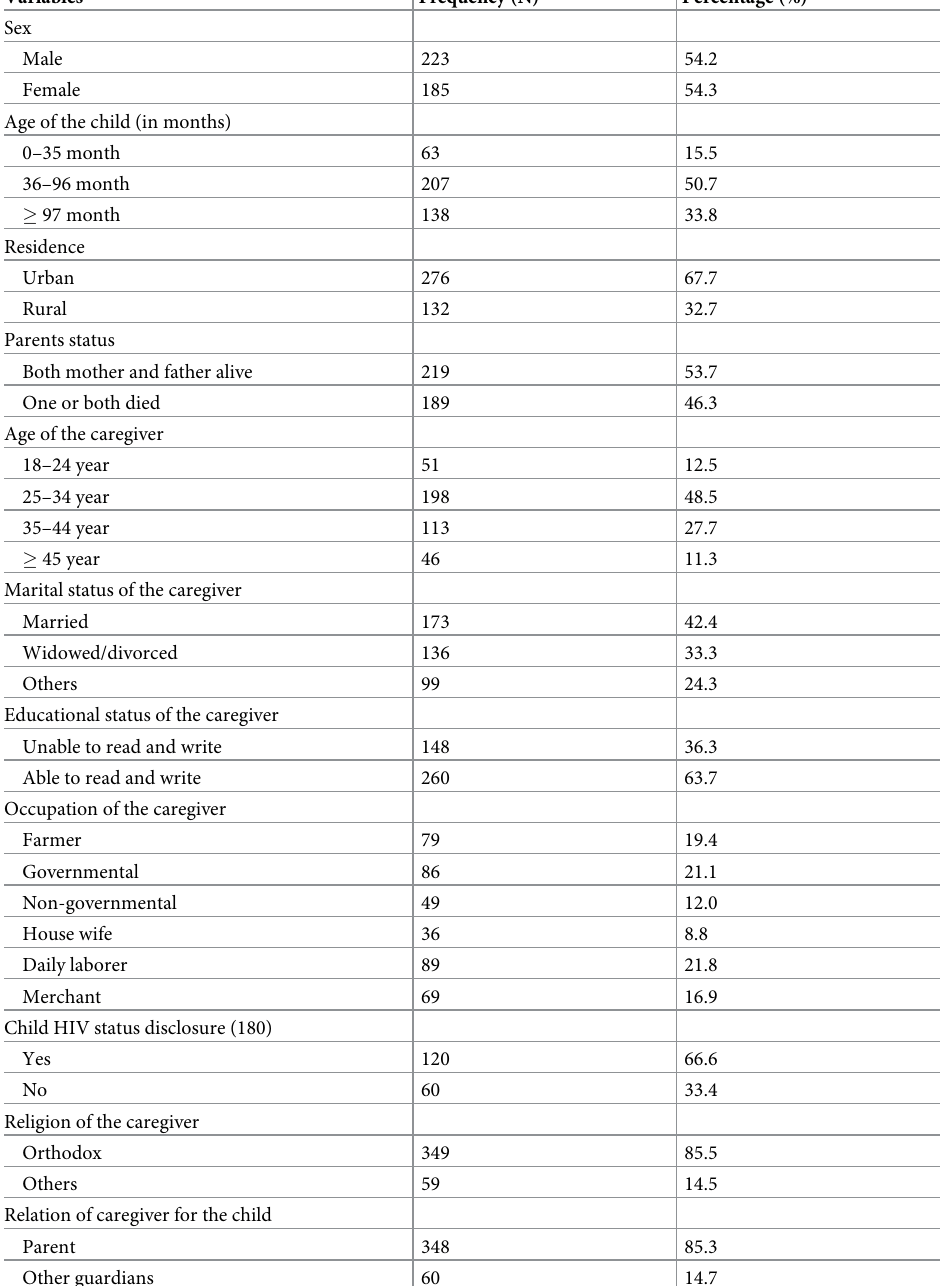
Table 1. Sociodemographic characteristics of HIV-infected children receiving ART at Debre-Markos Referral Hospital, Northwest Ethiopia, 2019.